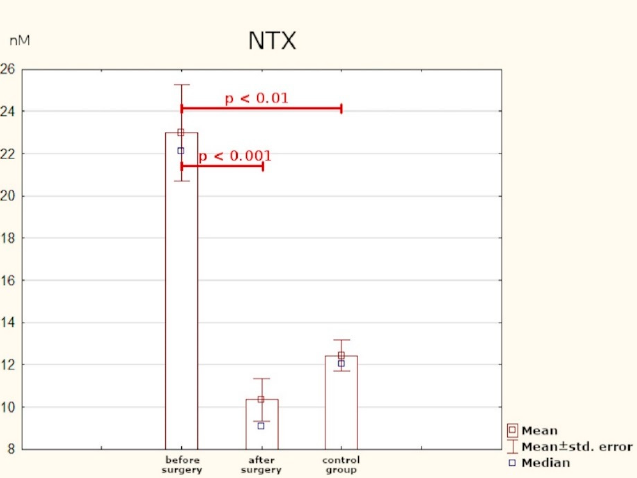
Figure 6. Serum concentrations of NTX.